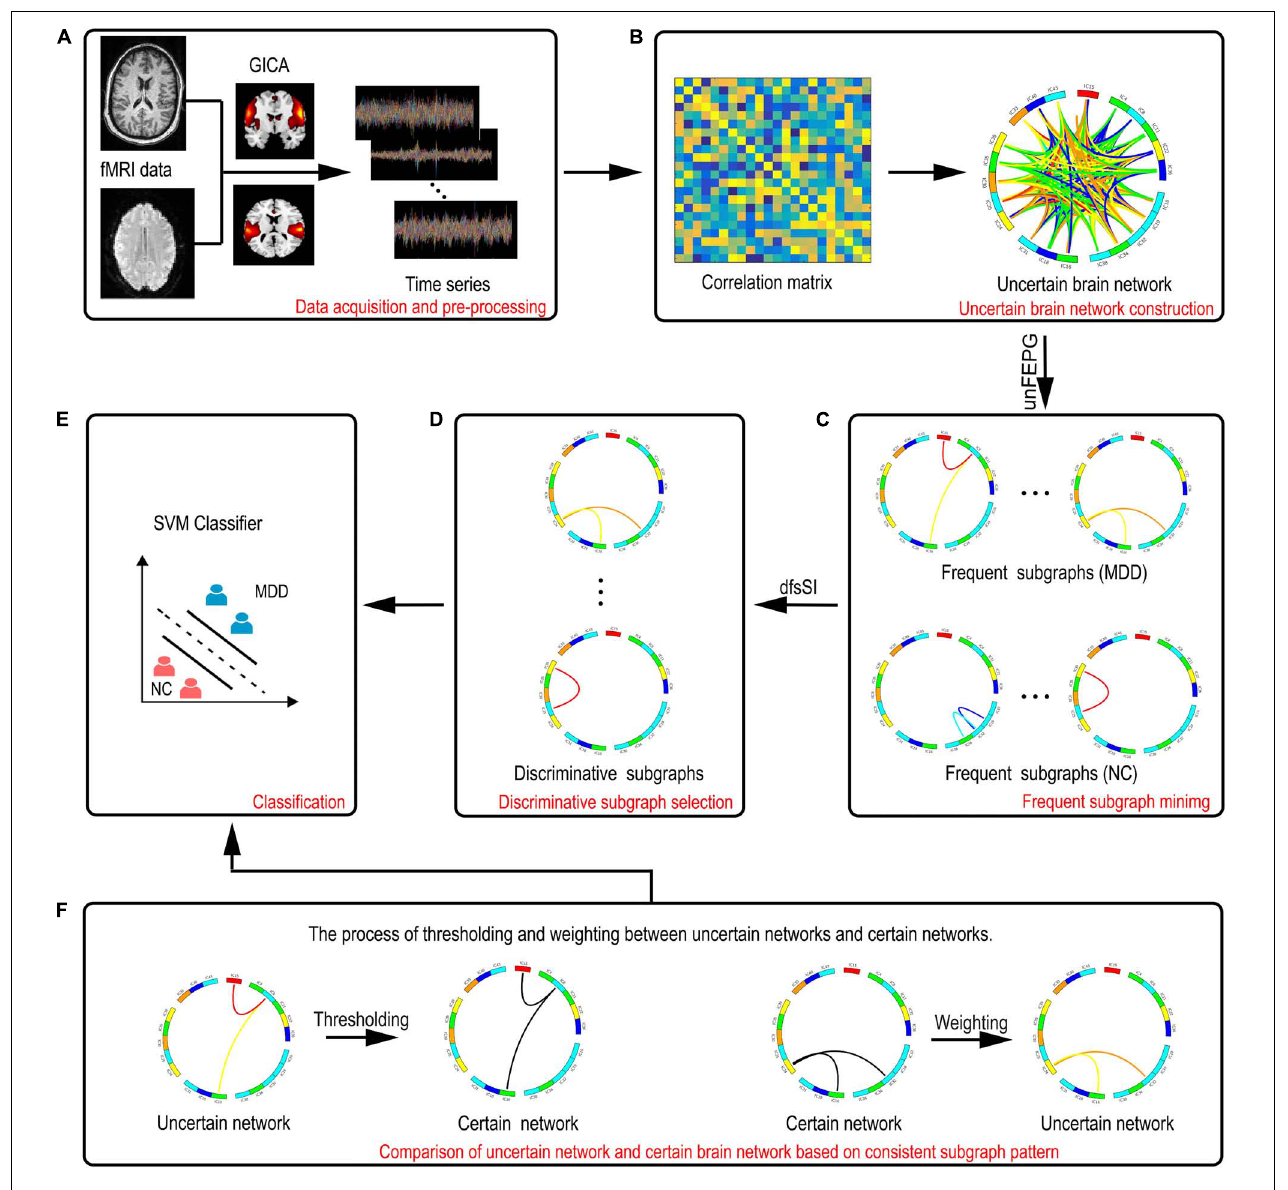
FIGURE 1 | A description of the entire framework for the proposed method. (A) Data acquisition and preprocessing. (B) Construction of the uncertain brain network. (C) Frequent subgraph mining. (D) Discriminative subgraph selection. (E) Classification. (F) Comparison of the uncertain network and certain brain network based on consistent subgraph patterns. The left graph represents thresholding of discriminative subgraphs in the uncertain network. The right graph represents the weighting of discriminative subgraphs in the certain